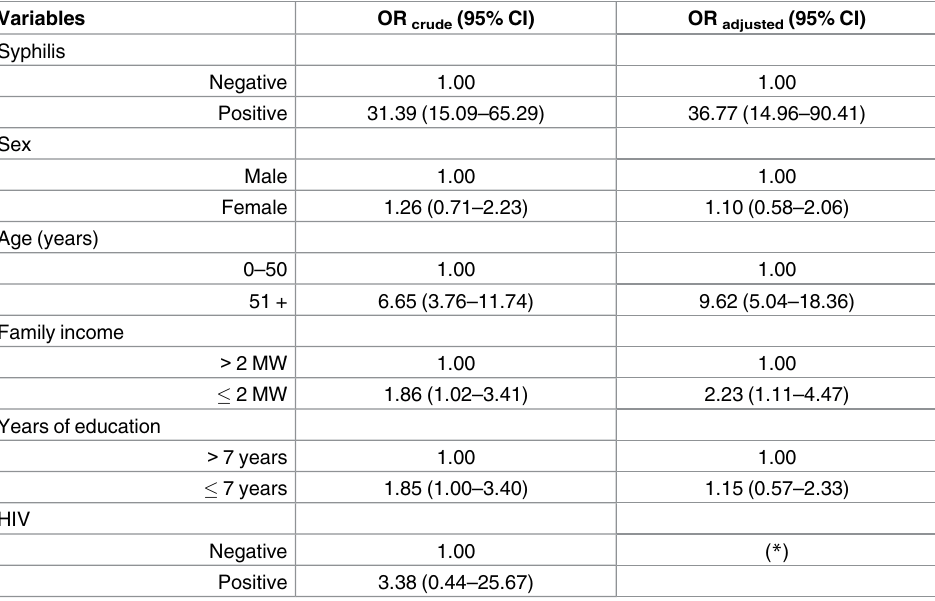
Table 2. Crude and adjusted Odds Ratios (OR) regarding the association of HTLV-1 infection and syphilis, adjusted for sex, family income, age, yearsof education and HIV infection in Salvador, North- east